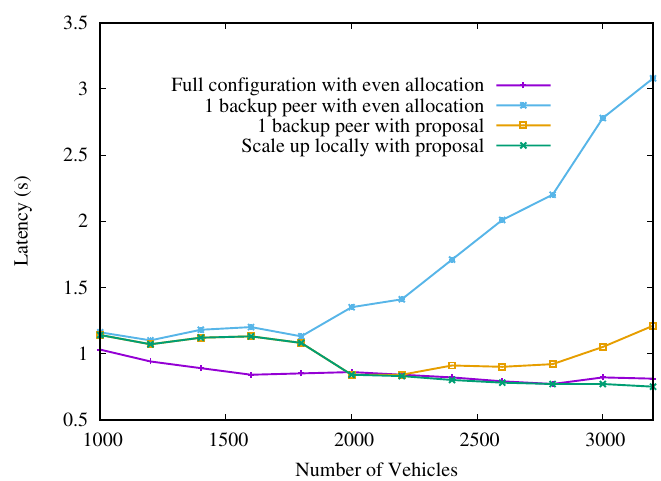
Figure 13. Latency performance of the system with a backup